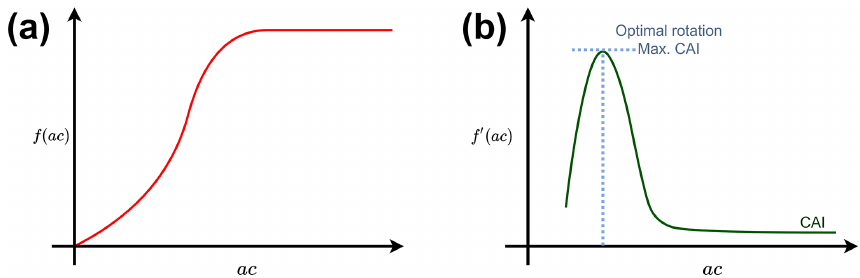
Figure 3. Qualitative representation of the rotation length calculation using a single-rotation model in MAgPIE based on Amacher et al. (2009). The x axis represents the age-class equivalent of rotation lengths. Panel (a) shows an S-shaped growth curve calculation for every MAgPIE cluster. Panel (b) presents the first derivative of these cluster-specific carbon densities.